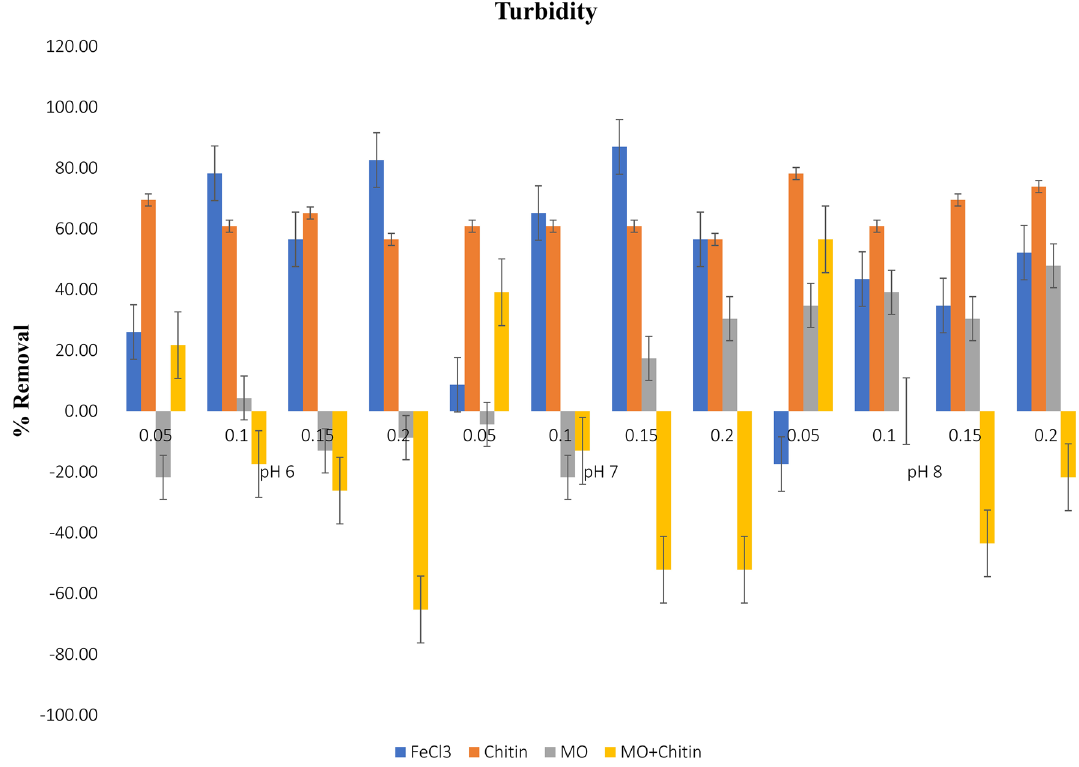
Fig. 1 Turbidity comparison of the